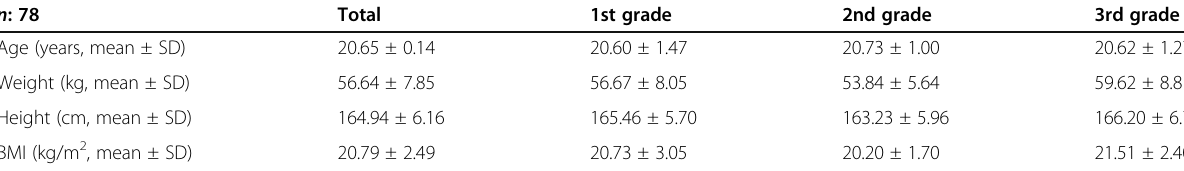
Table 1 The physical characteristics of all participants and the groups n : 78